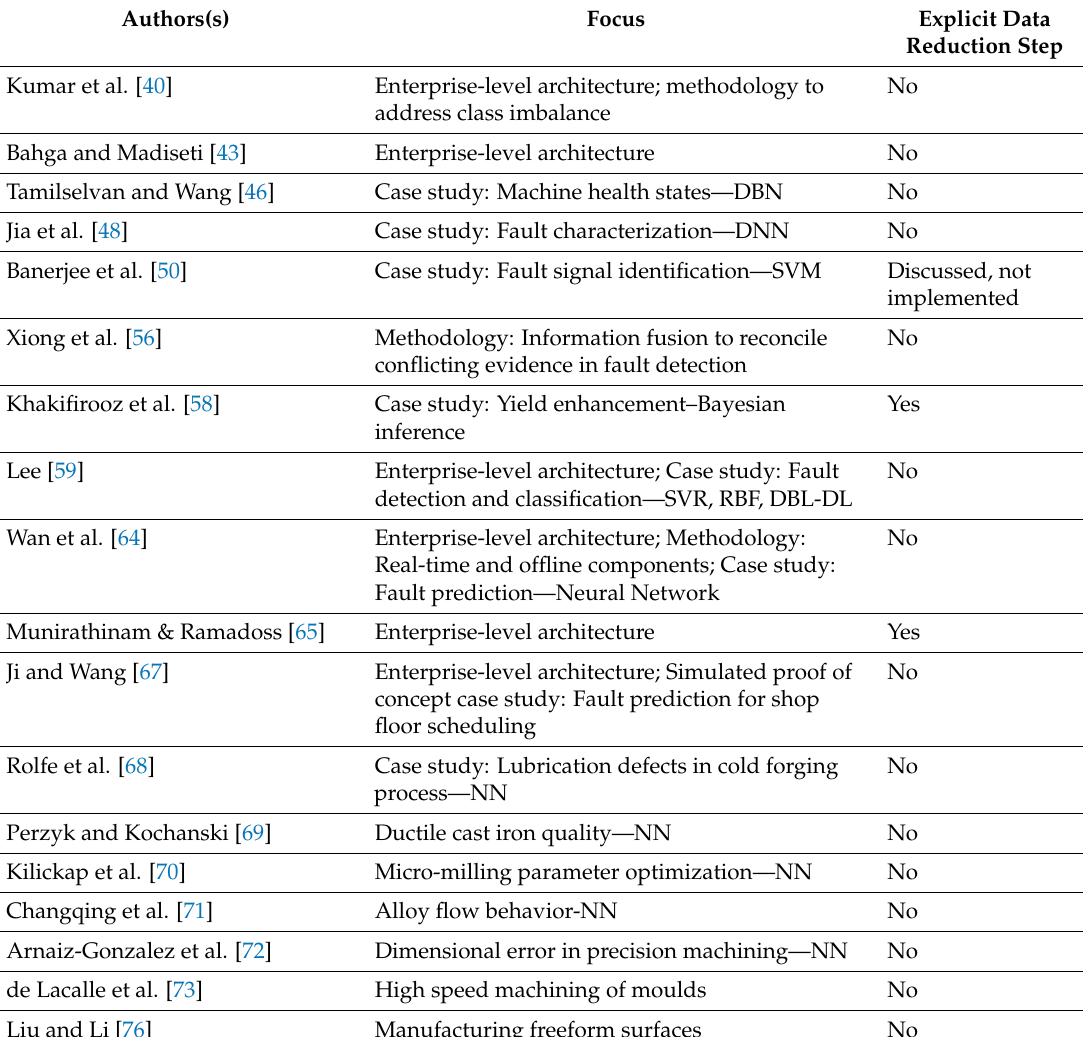
Table 3. Big data approaches for specific industrial